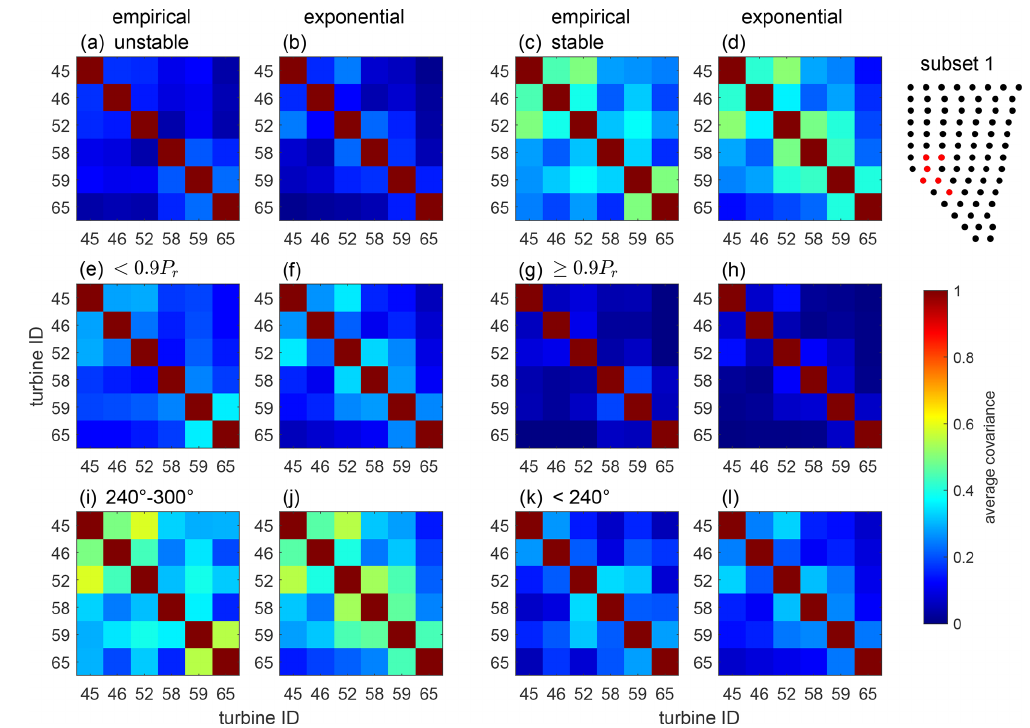
Figure 12. Average covariances of turbine subset 1 determined using the empirical (left: a, c, e, g, i, k ) and exponential (right: b, d, f, h, j, l ) copula approaches. Unstable (a, b) and stable (c, d) cases and situations with turbines operating below ( < 0 . 9 P r ) (e, f) and at rated power ( ≥ 0 . 9 P r ) (g, h) are compared. In (i) – (l) stable situations with turbines operating below rated power with wind directions ranging from 240–300 ◦ (i, j) and < 240 ◦ (k, l) are depicted. The turbine subset 1 is marked in red in the small wind farm